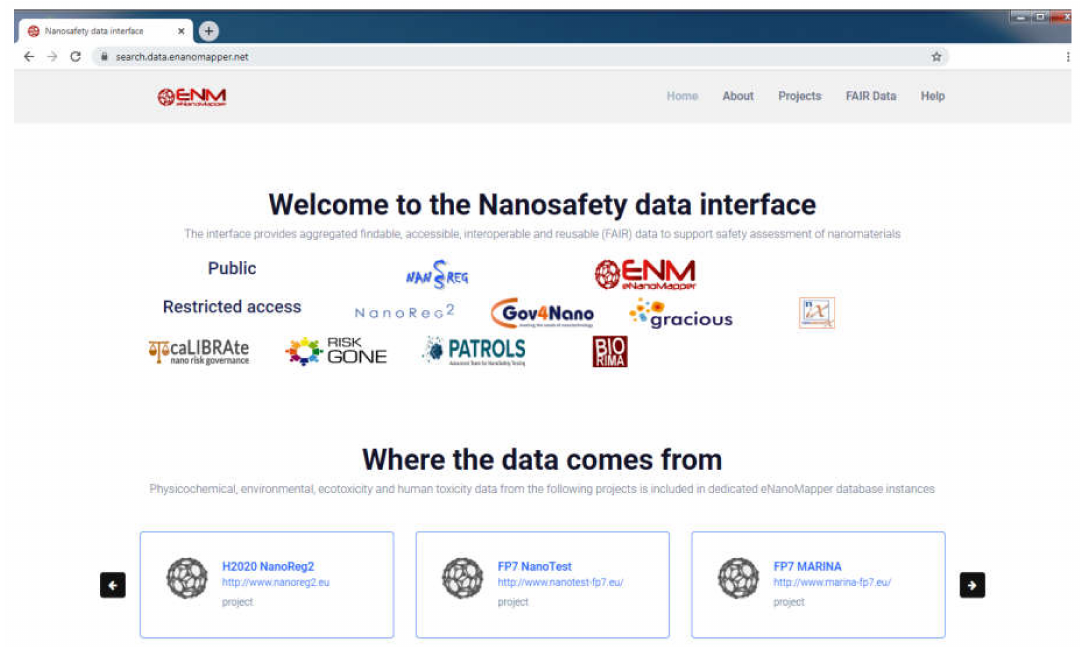
Figure 13. Screenshot of the entry page of the Nanosafety data interface to the eNanoMapper database’s web